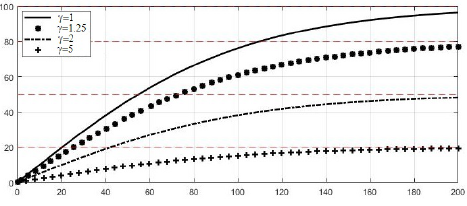
Figure 2. Graphics of the function f 2 ( β ) for various γ ; h = 0 .